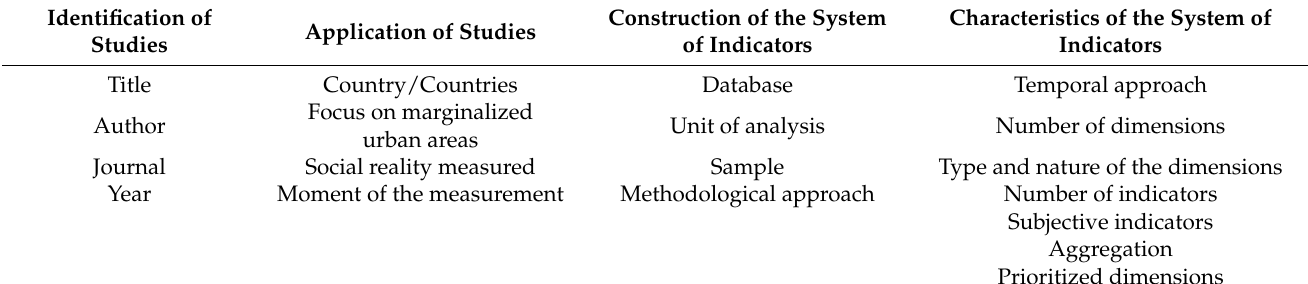
Table 1. Axes of systematization for the systematic